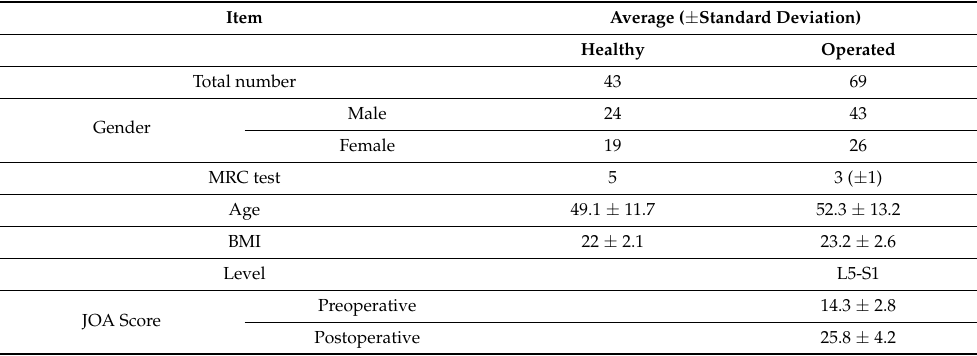
Table 1. Demographic characteristics of healthy and operated subjects.